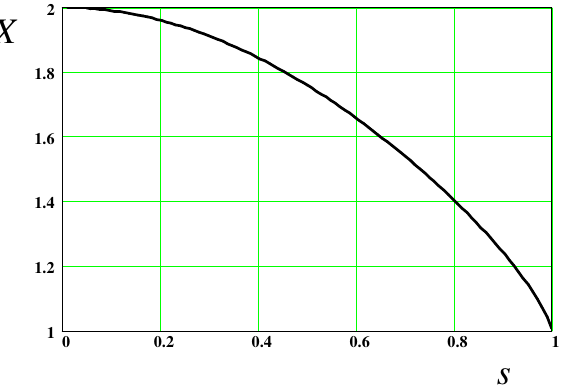
Figure 5. The dependence of X = σ p / p 0 on the stretching degree s = R / L